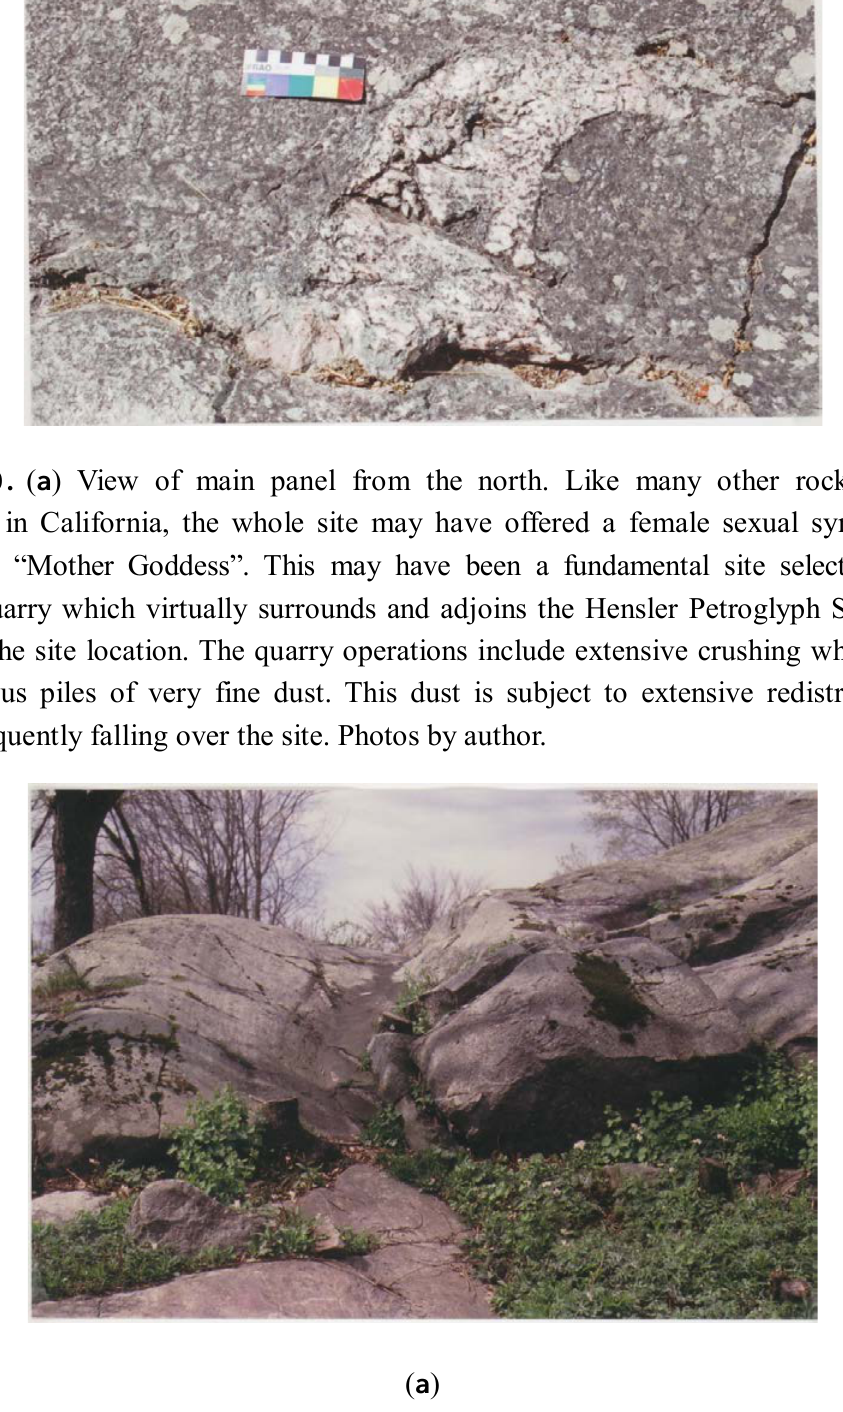
Figure 19. An “eagle head” comprised of a quartz vein in the main panel at the Hensler Petroglyph Site. With engravings all around it, this natural feature may follow the idea of “expedient imagery”, and may, in fact, have been a site selection factor. Photo by author.